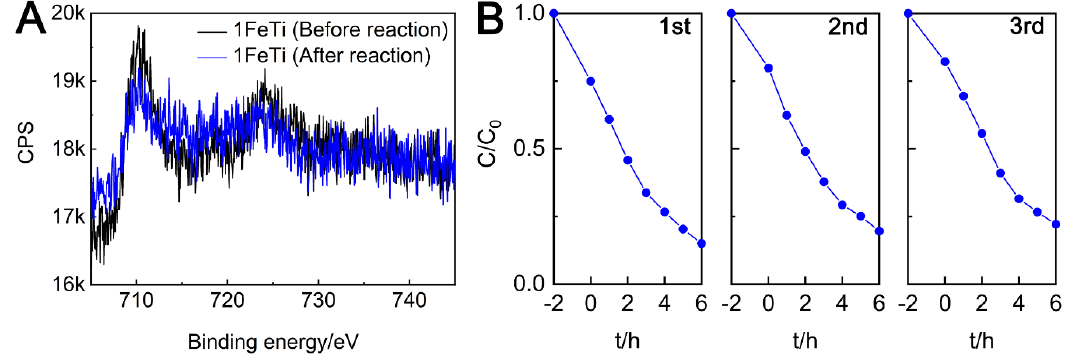
Figure 9. Recyclable performance of 1FeTi under visible light irradiation: ( A ) XPS Fe 2p spectra of 1FeTi before and after photodegradation; ( B ) Photodegradation performance of 1FeTi in the RhB solutions within three cycles.